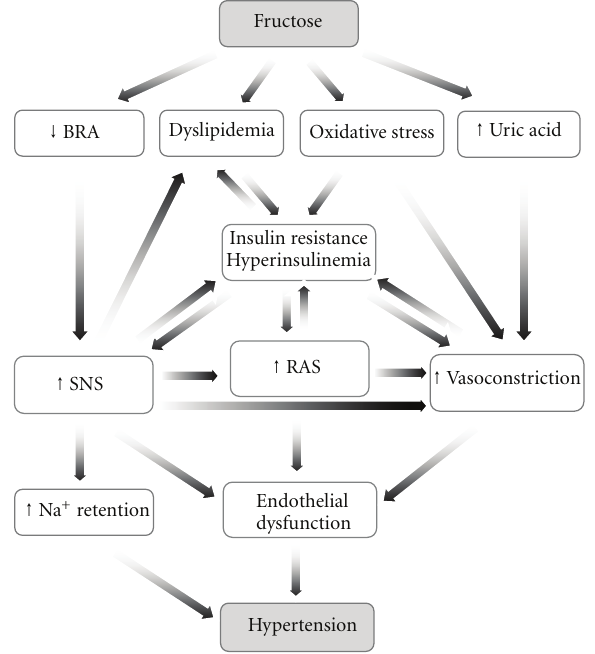
Figure 1: The proposed mechanisms by which fructose feeding results in hypertension. BRA: baroreflex sensitivity; SNS: sympa- thetic nervous system; RAS: renin-angiotensin